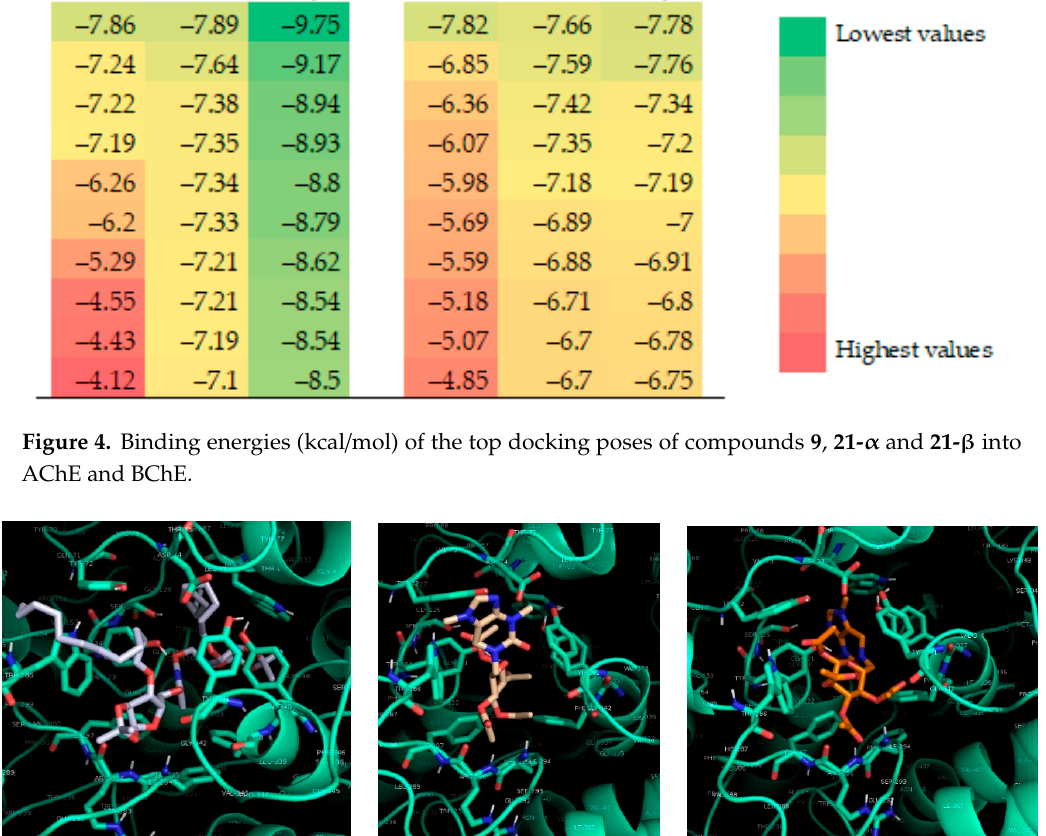
Figure 5. Lowest-energy binding poses of compounds 9 , 21- α and 21- β to AChE.